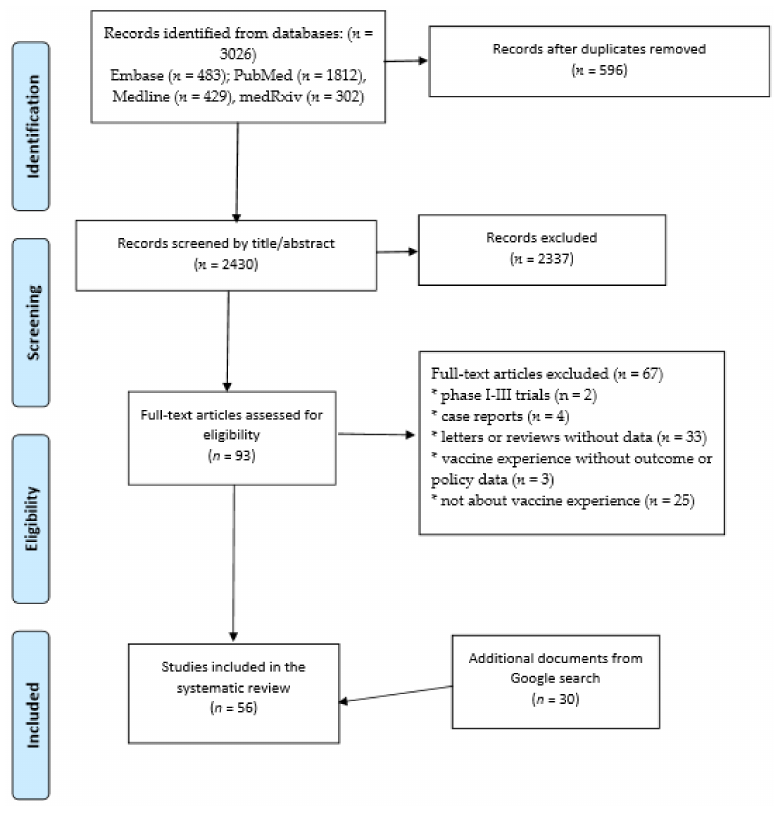
Figure 1. PRISMA Flow diagram for study inclusion in the systematic